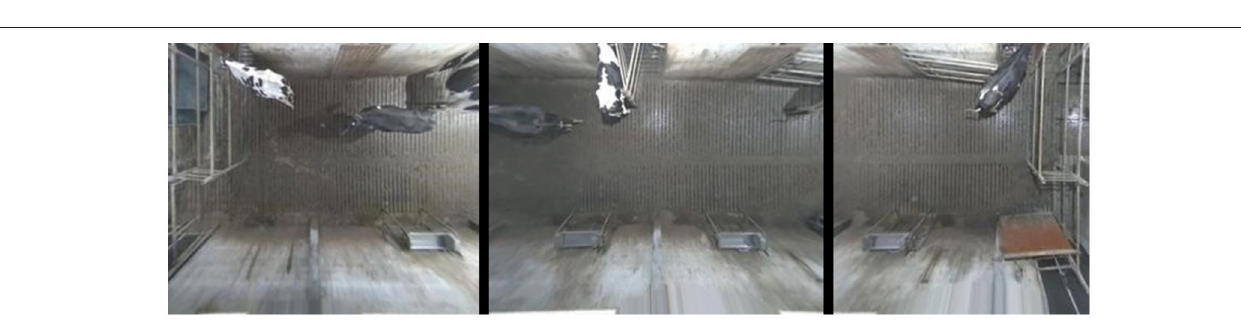
time, which makes sense as the position of the object typically is the part of its